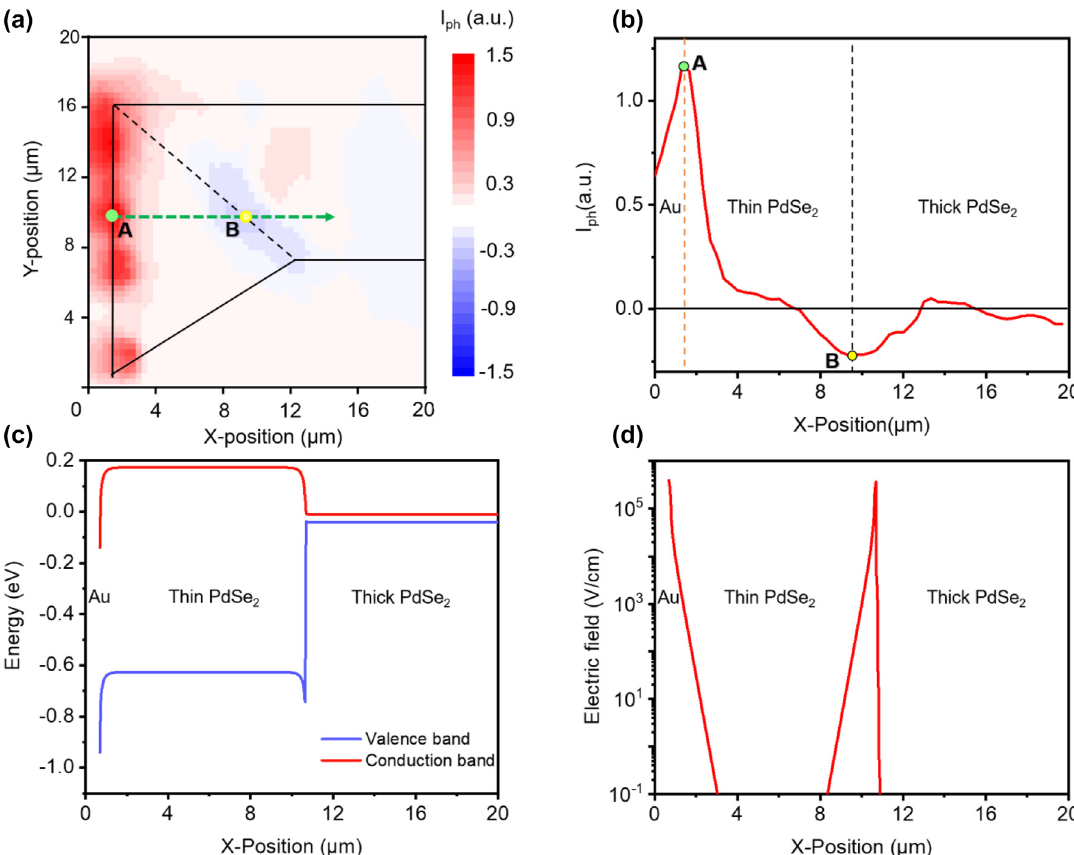
Figure 2: The photoresponse mechanism of the PdSe photodetector. (a) The local laser-induced photocurrent mapping exhibits ambipolar 2 photocurrent-generation origins in the “thin-Au” contact and “thin–thick” interface. The black dashed line indicated the whole outline of the PdSe 2 nanoflake in the channel. (b) The photocurrent distribution measured along the green dashed line in (a) presents an asymmetric ambipolar photodetector with asymmetric vdWs contacts. (d) The photocurrent existing along the channel. (c) The simulation of the bandgap of the thin PdSe 2 simulated electric field distribution along the device